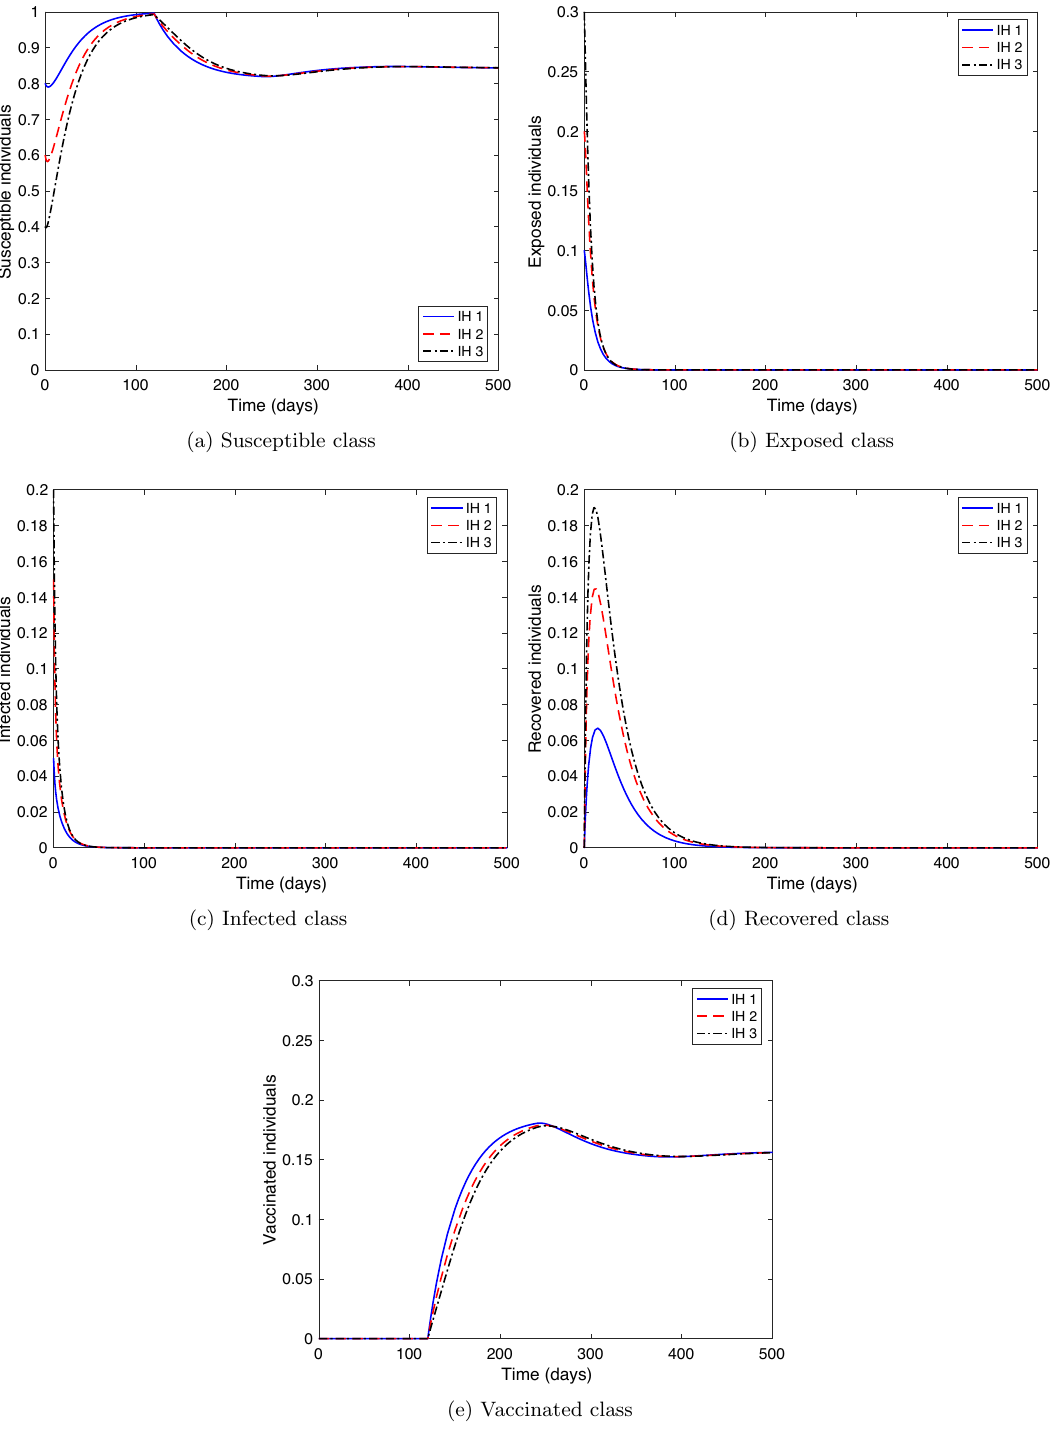
Figure 2. Numerical solution of system (25) versus time with different initial histories for R c < 1 and τ